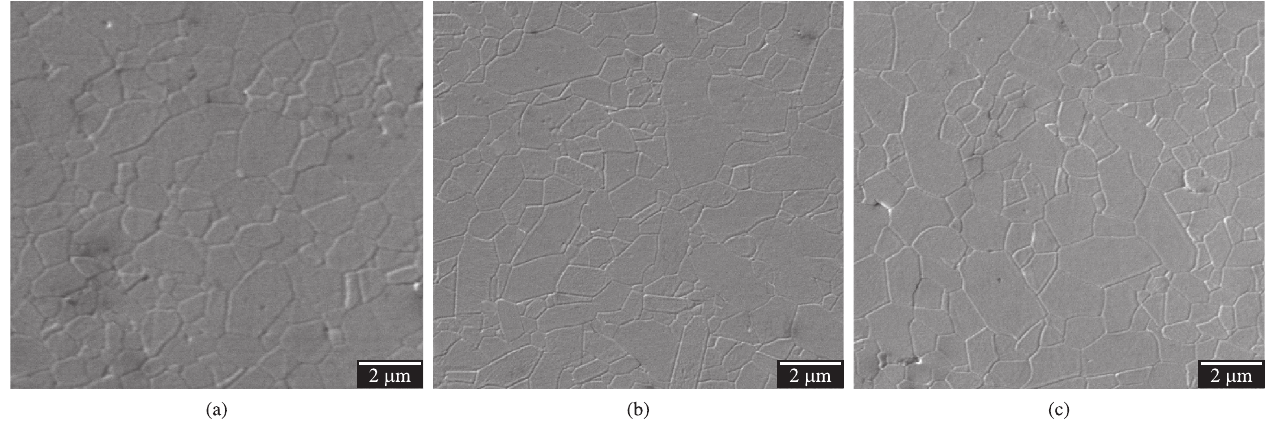
Figure 3. SEM micrographs of the conventionally sintered samples: a) at 1450 °C for 2 hours; b) at 1500 °C for 2 hours; and c) at 1500 °C for 6 hours.